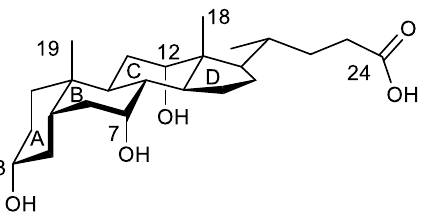
Figure 1. Structure of cholic acid. Significant carbon atoms are numbered as well as the four rings of the steroid nucleus. In the text, the numbers of oxygen atoms are those of the carbon atoms to which they are bonded.